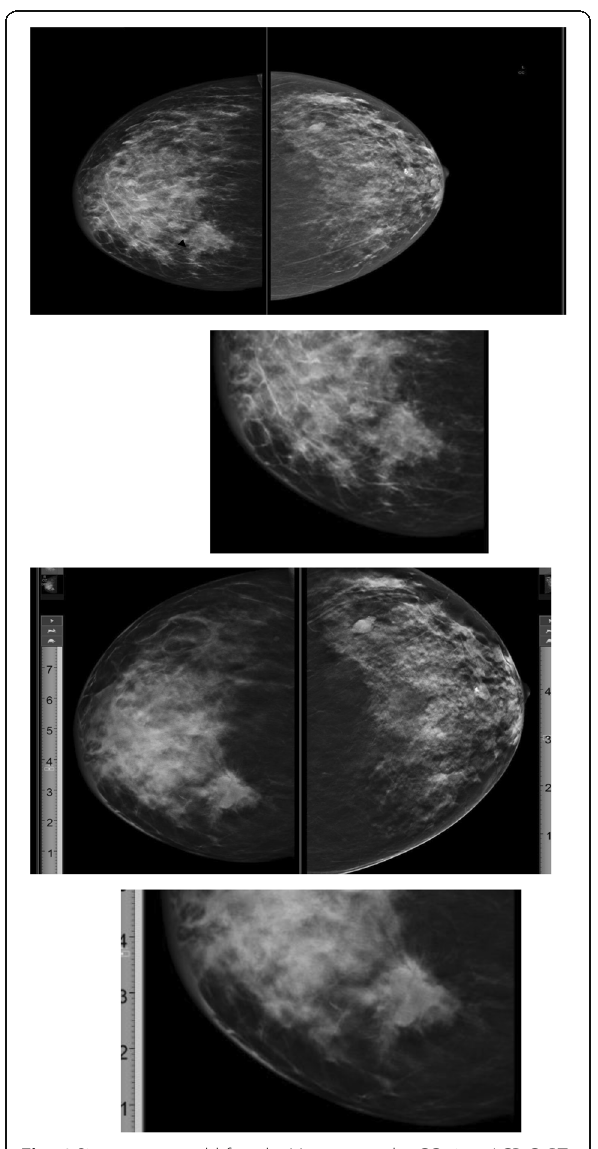
Fig. 6 Sixty-one-year-old female. Mammography CC view ACR C, RT UIQ obscured dense lesion, BIRADS 3. Tomosynthesis CC view Rt UIQ irregular speculated dense lesion, BIRADS 4C. The margin of the lesion appeared speculated on 3D digital tomosynthesis images (BIRADS 4), which was proved to be duct carcinoma